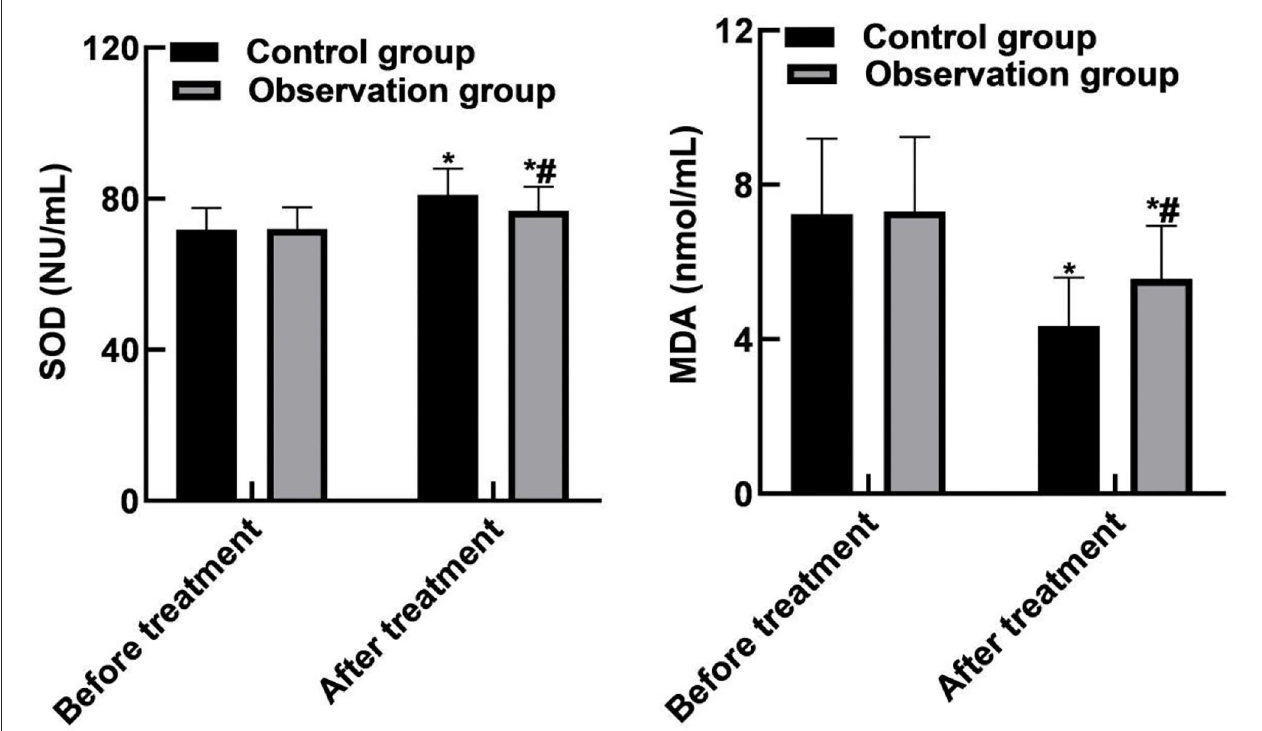
FIGURE 4 | Comparison of oxidative stress indicators between the two groups. Compared with before treatment, * P < 0.05. Compared with the control group, # P < 0.05.